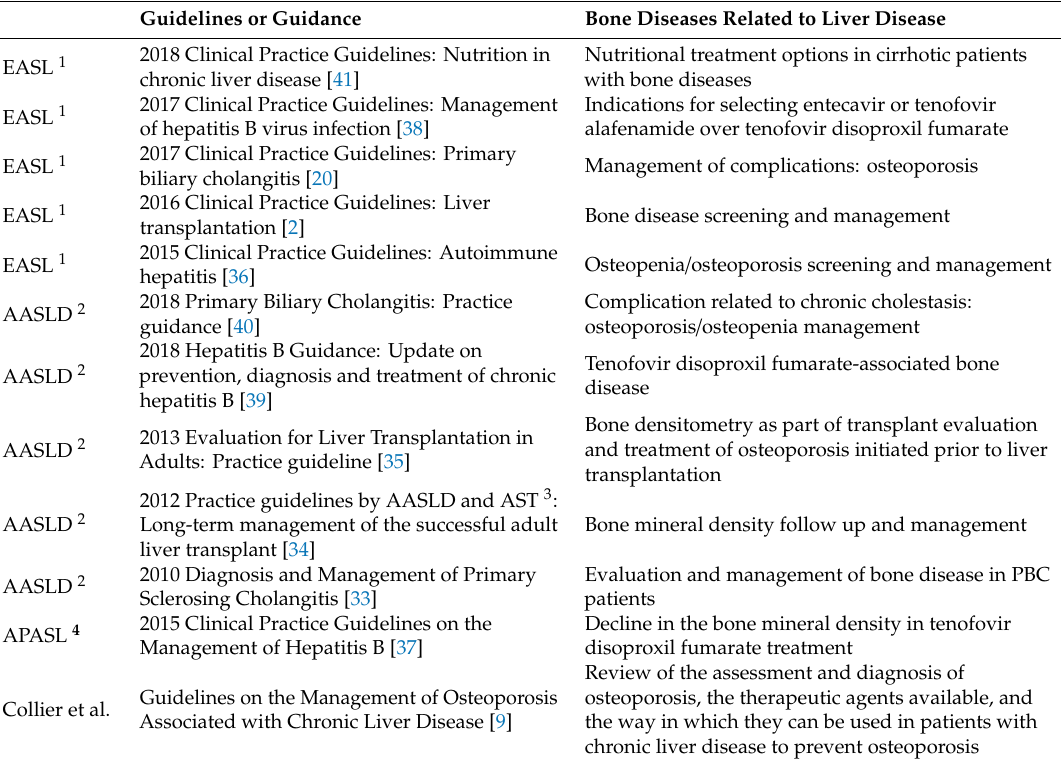
Table 1. Guidelines for bone diseases in patients with chronic liver